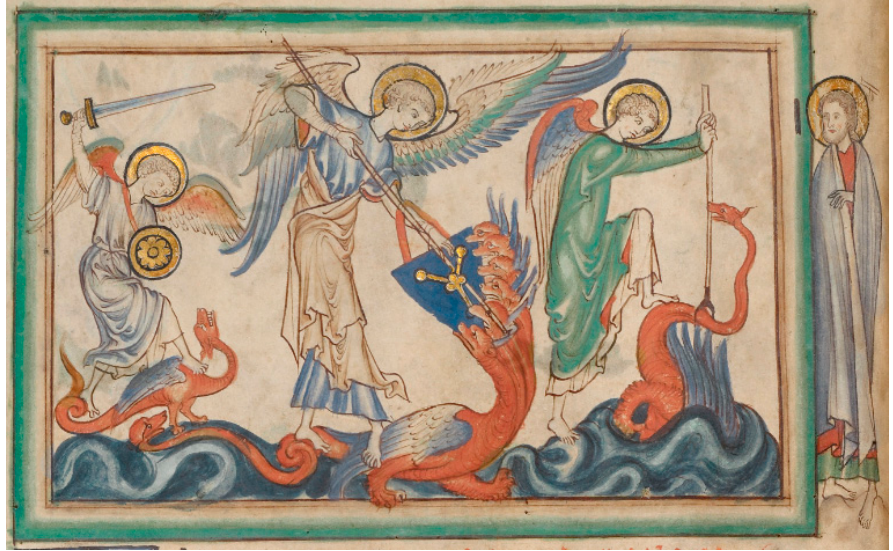
Figure 5. Getty or Dyson Perrins Apocalypse. Los Angeles, J. Paul Getty Museum MS Ludwig III.1, Fol. 20v, c. 1255–60. Digital image courtesy of the Getty’s Open Content Program.